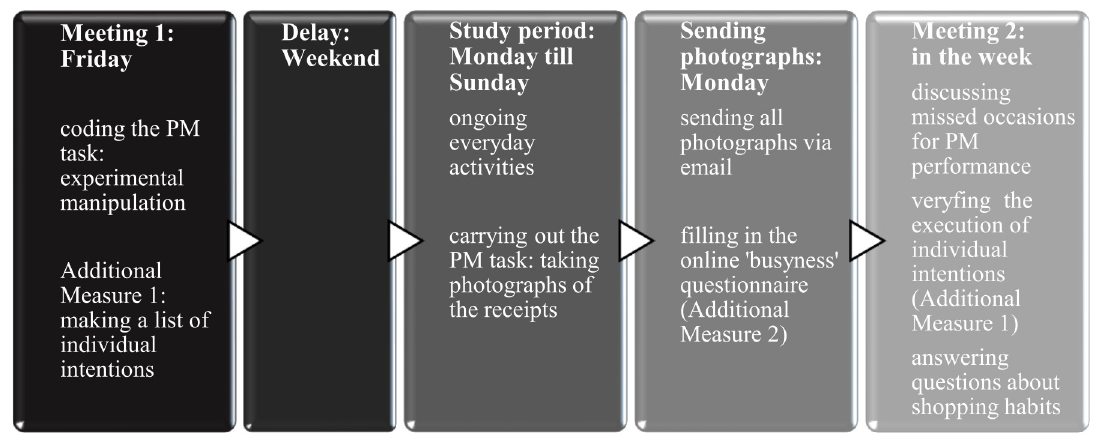
Fig 2. A summary of the experimental procedure.